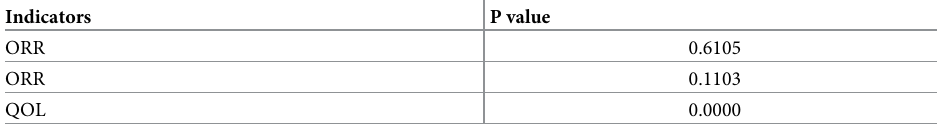
Table 7. Egger’s test of ORR, DCR and